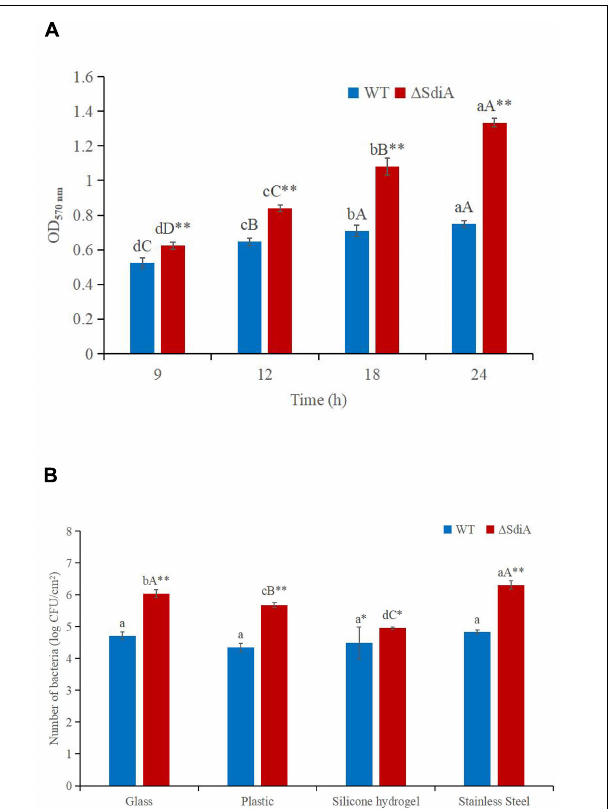
FIGURE 4 | C. sakazakii WT and (cid:49) sdiA mutant strains biofilm formation and surface adhesion capabilities assay. (A) Optical density values of CV solutions obtained from biofilms of C. sakazakii WT and (cid:49) sdiA mutant strains grown in the TSB at 37 ◦ C. a – d Mean values differ significantly in different time of each strain ( p < 0.05), A – D means ( p < 0.01); ∗∗ Mean values differ significantly between two strains in the same time ( p < 0.01). (B) Number of adhered C. sakazakii WT and (cid:49) sdiA mutant strains to different substratum. a Mean values differ significantly in different substratum of each strain ( p < 0.05), A – C means ( p < 0.01); ∗ Mean values differ significantly between two strains in the same substratum ( p < 0.05), ∗∗ means ( p < 0.01). Error bars represent standard deviation. All experimental data’s were plotted as mean ±